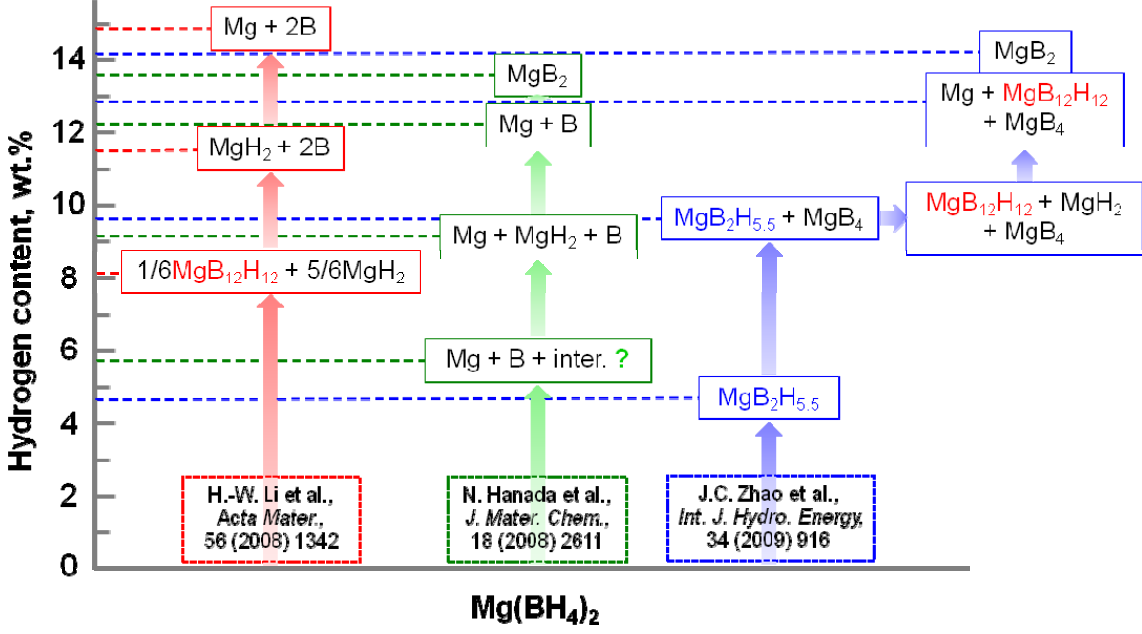
Figure 2. The dehydrogenation processes of Mg(BH Question mark indicates the possibility of the formation of an intermediate compound during the